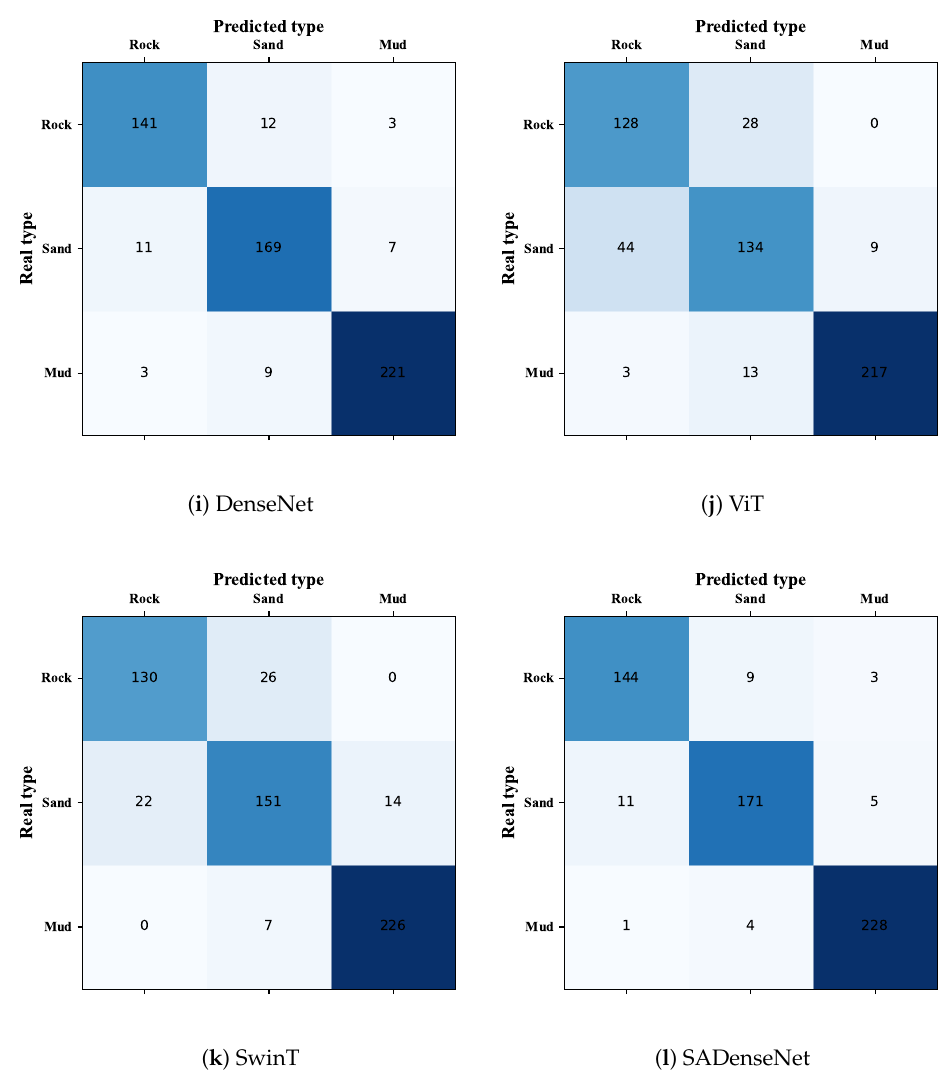
Figure 9. Confusion matrices of different classifiers trained with the original